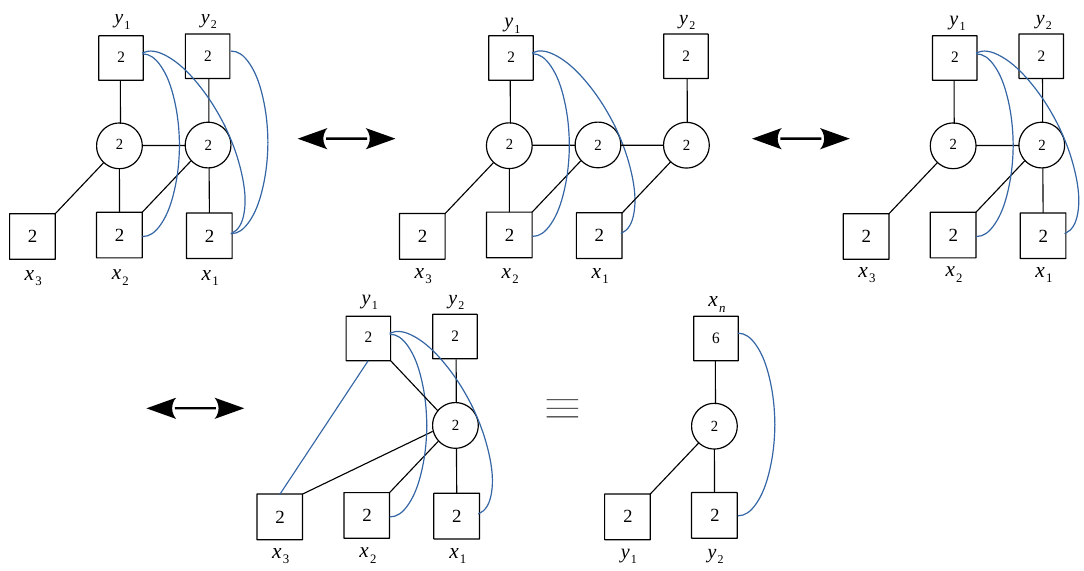
[USp(2 N )] and [ N (cid:0) 1 ; 1]